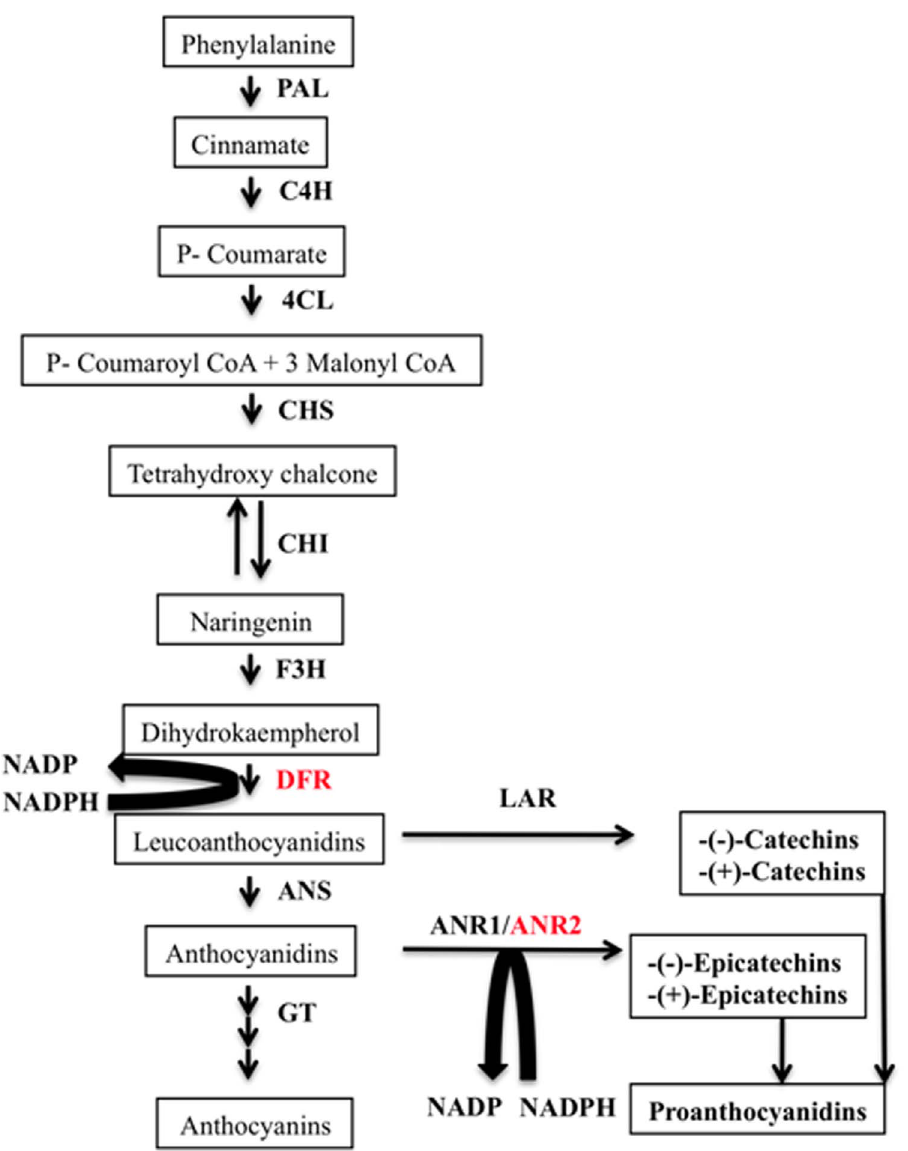
Figure 1. General outline of anthocyanins and flavan-3-ols biosynthetic pathway in plants. The enzymes are: PAL, Phenylalanine ammonia-lyase; C4H, cinnamate 4-hydroxylase; 4CL, 4-coumaroyl CoA-ligase; CHS, chalcone synthase; CHI, chalcone isomerase; F3H flavanone-3- hydroxylase; DFR, dihydroflavonol 4-reductase; LAR, leucoanthocyanidin reductase; ANS, anthocyanin synthase; ANR1, anthocyanin reductase1; ANR2, anthocyanin reductase2; GT, Glucosyl transferase.